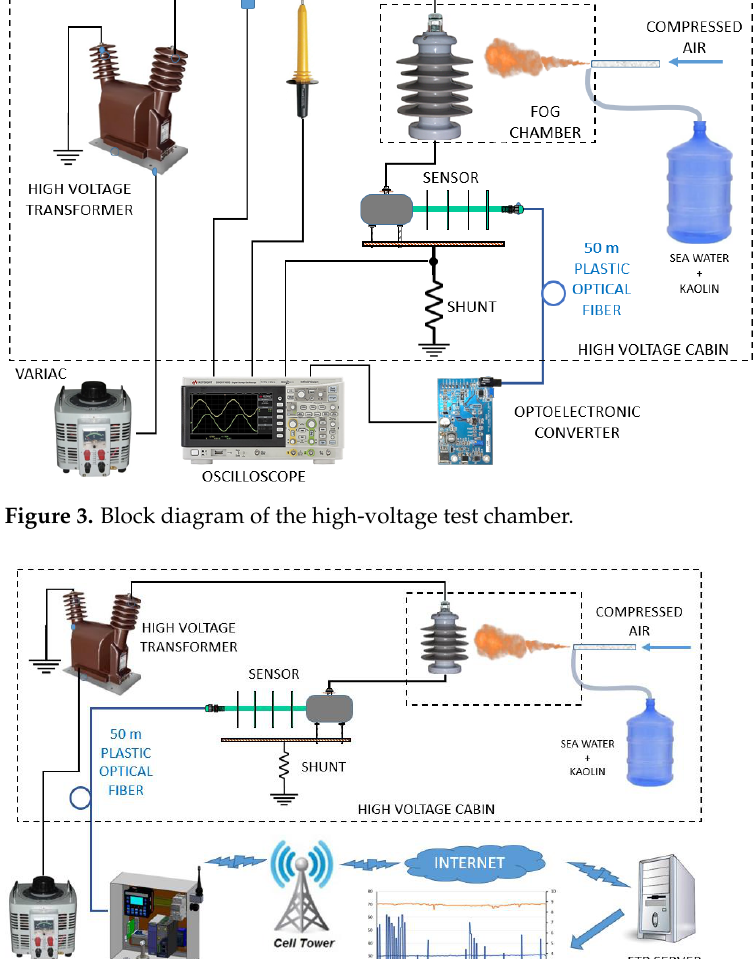
Figure 4. Block diagram of the transmission chain, starting at the current sensor, optical fiber cable transmission, the OSM, PLC, and router inside the remote unit, the GPRS transmission, the internet, and the data arriving via CSV at the laboratory server.